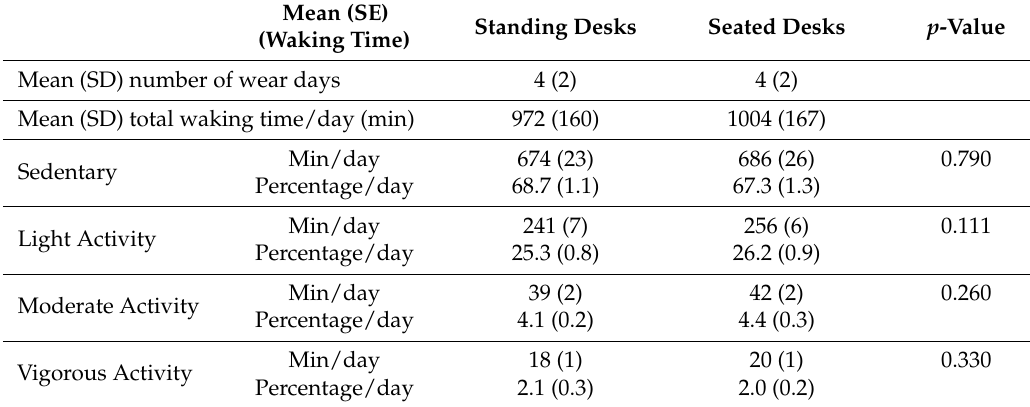
Table 1. Comparison of mean (SE) sedentary time and time spent in light, moderate and vigorous physical activity during waking time between standing desk and seated desk conditions.